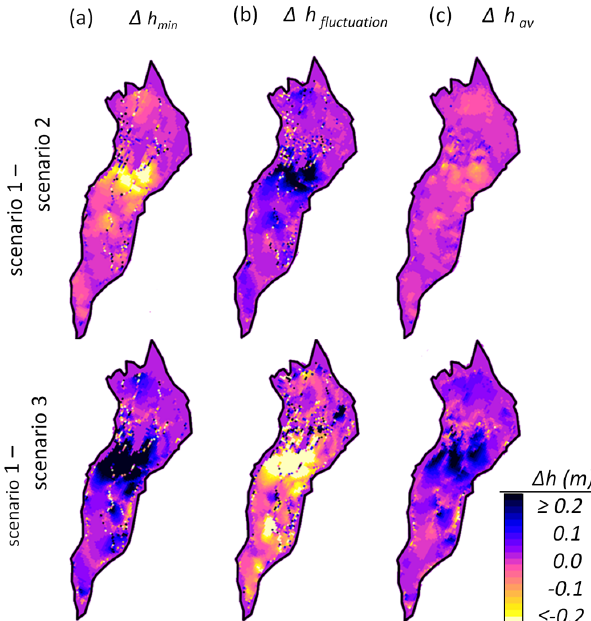
Fig. 10. The simulated groundwater level behaviour – difference between the four scenarios.